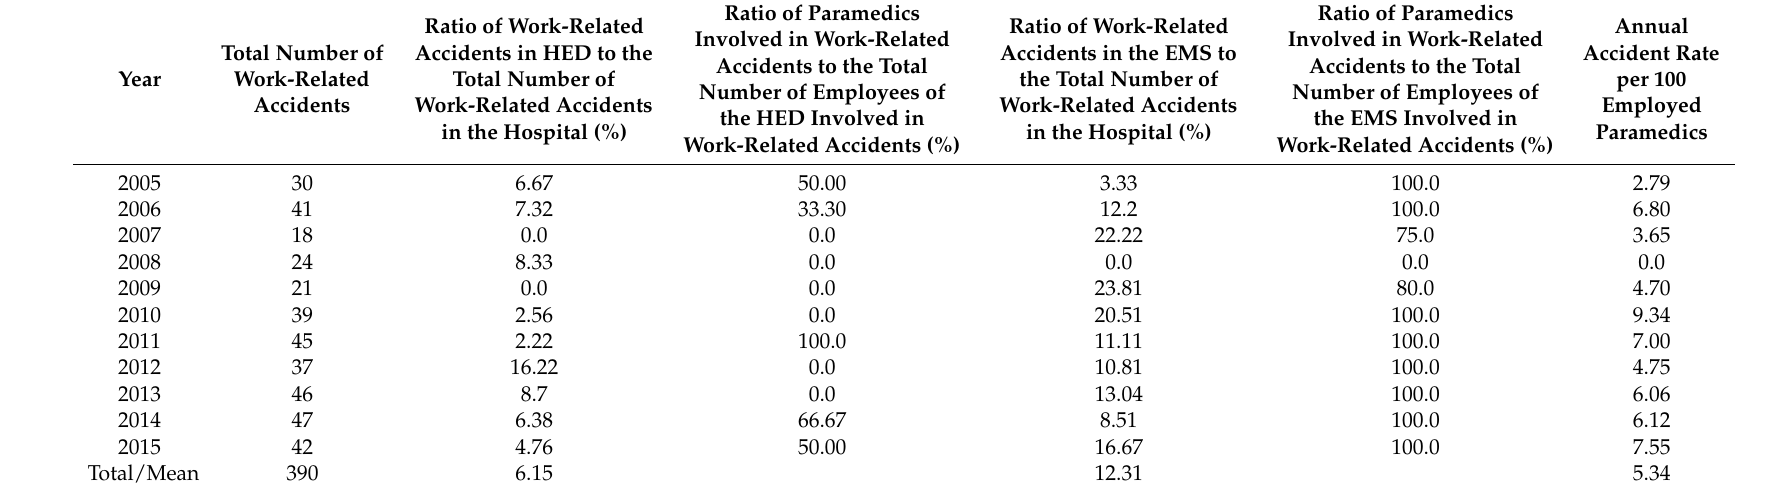
Ratio of Paramedics Involved in Work-Related